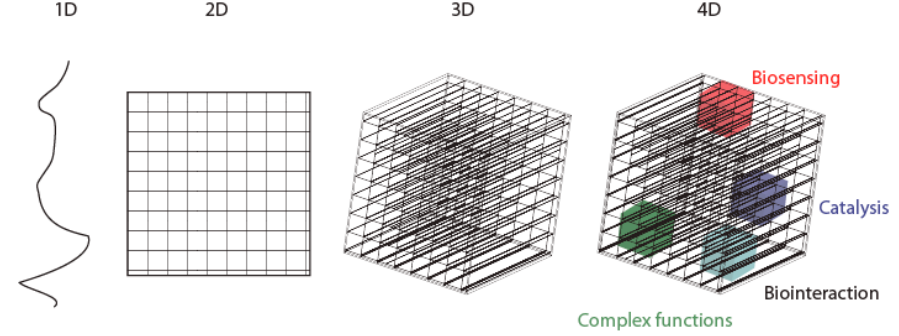
Figure 1. From 1D to 4D concept: 4D printing is adding new capabilities to multi-material 3D-printed objects: either physical, electronic, chemical, biological or biochemical properties.